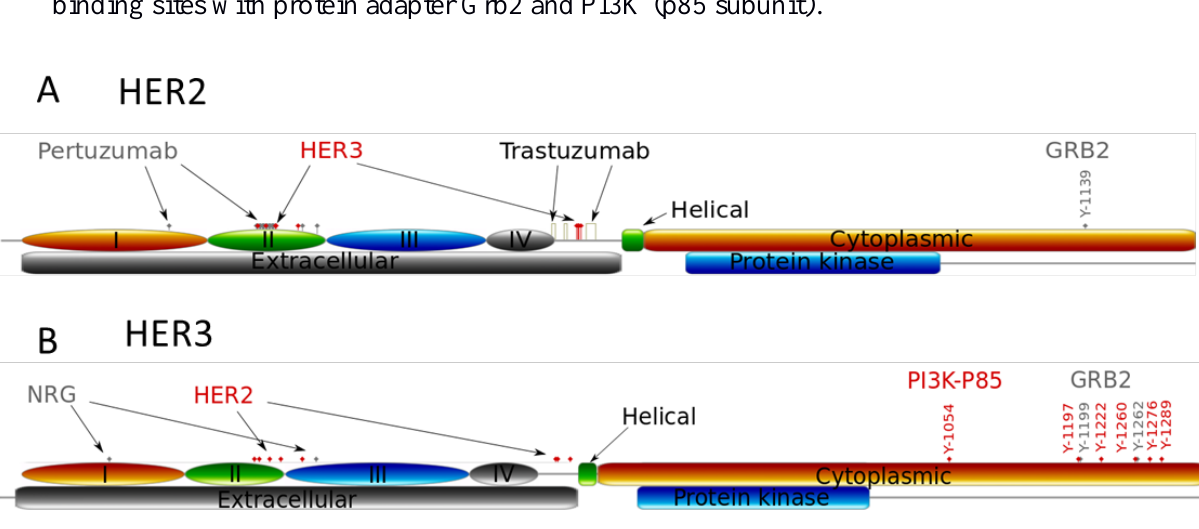
Figure 3. Schematic structures of the extra- and intracellular domains of receptors HER2 ( A ) and HER3 ( B ). Structures show the binding sites of pertuzumab, trastuzumab, HER2 and HER3, the receptor dimerization sites of the receptors, and the phospho-tyrosine binding sites with protein adapter Grb2 and PI3K (p85